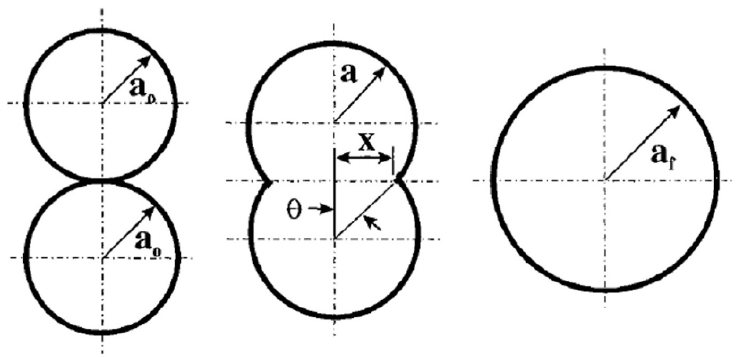
Figure 13. Schematic representation of particle coalescence according to Frenkel’s model. Reproduced with permission from [108].